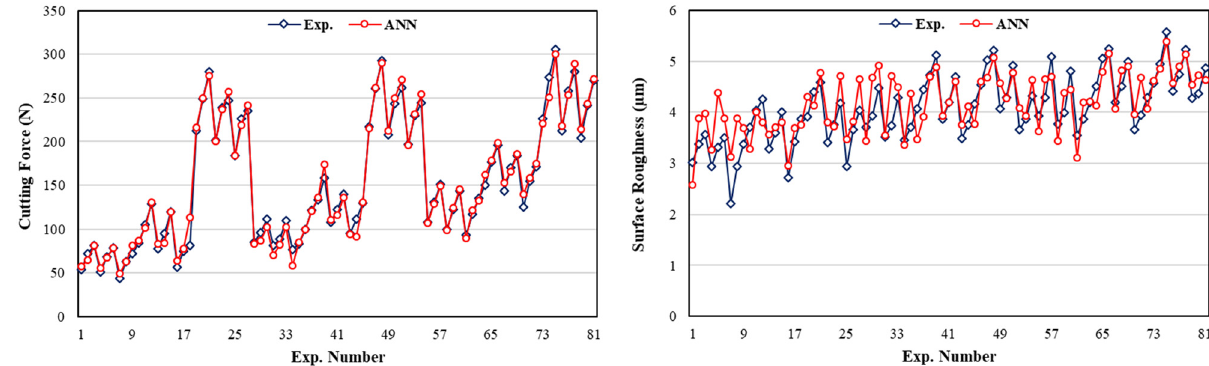
Figure 12: Comparison of experimental data with predicted results from ANN.